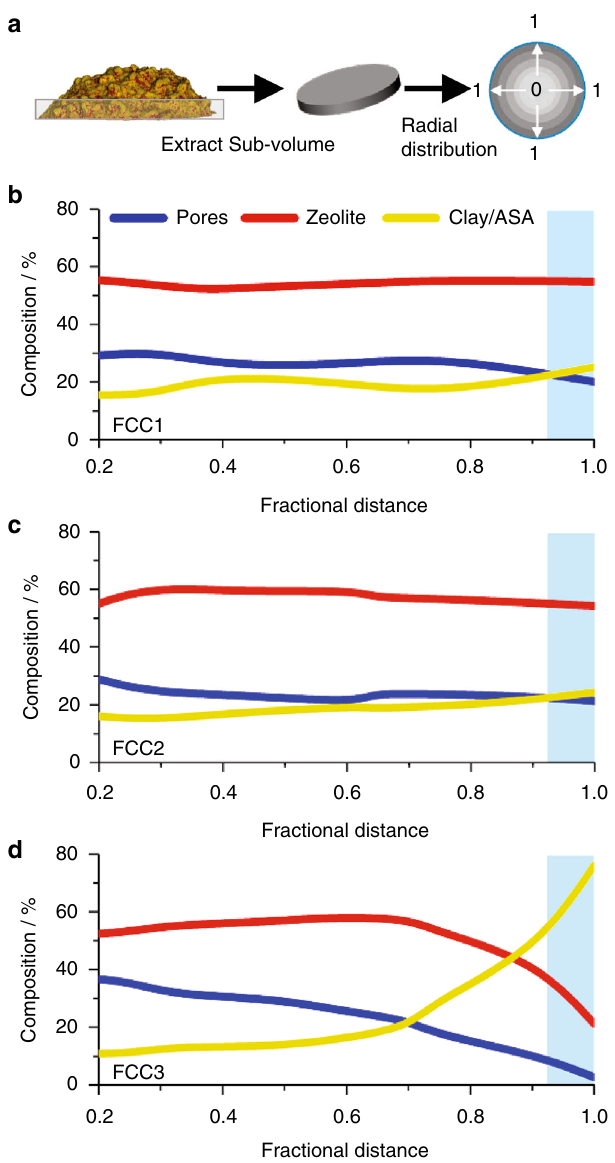
Fig. 4 Radial distribution pro fi les of FCC catalyst components. a Segmented tomograms (Fig. 3) were cropped along the y -axis to obtain cylindrical subvolumes of the tomogram base (2 µ m in height). As a function of fractional distance to the particle exterior, these subvolumes were analyzed in regard to volumetric composition of pores, zeolite, and the grouped clay/ASA fraction. The center of the extracted sub-volume is equal to 0 and the exterior surface is equal to 1. Plotted in b – d are the volumetric compositions of FCC1, FCC2, and FCC3, respectively. Highlighted in blue is a projected shell region ~1.5 µ m in